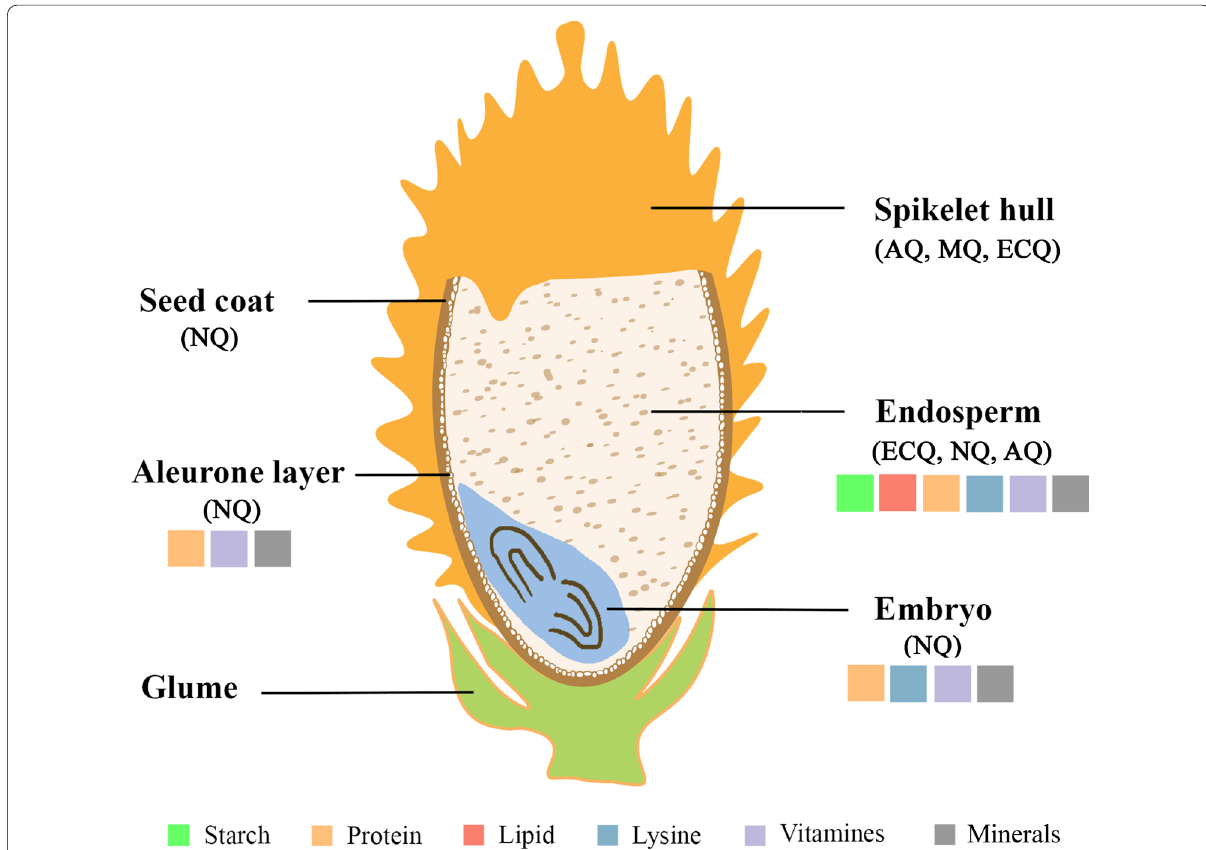
Fig. 2 Overview of the main structure and components based on the longitudinal section of mature rice seeds. AQ, appearance quality; MQ, milling quality; NQ, nutritional quality; ECQ, eating and cooking quality. Not drawn in